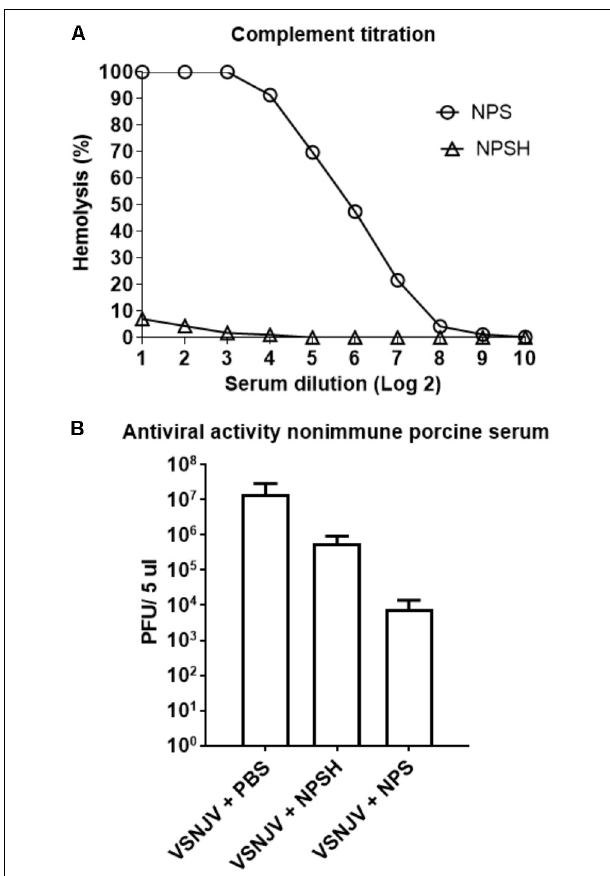
FIGURE 11 | Non-immune porcine serum (NPS) neutralizing activity. (A) The number of complement units in NPS and heat-inactivated NPS (NPSH) were determined by standard hemolysis technique. (B) The ability of NPS or NPSH to neutralize VSNJV infection was determined by plaque assay. As a negative control de virus was incubated with